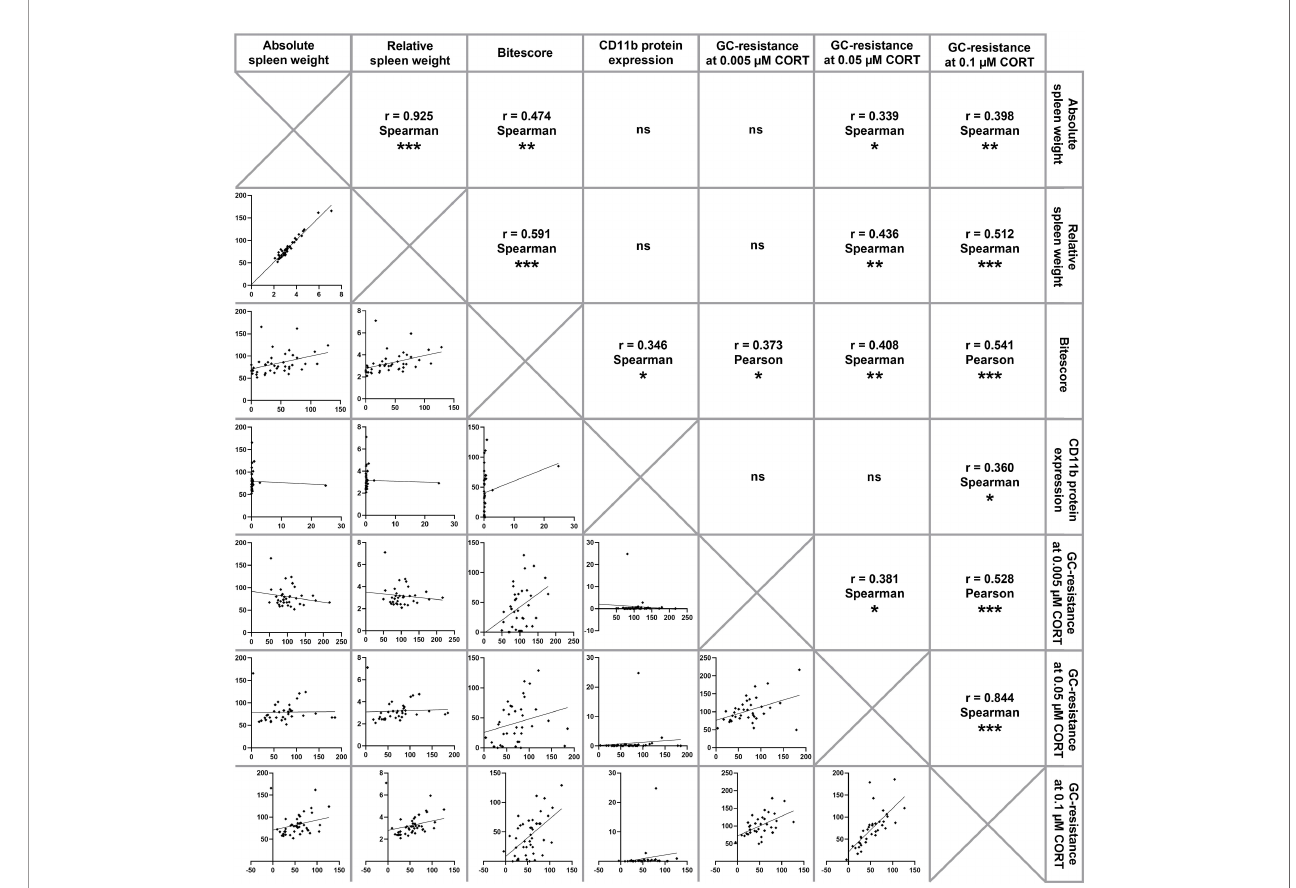
FIGURE 3 | Correlation analysis. Depicted are correlations between absolute and relative spleen weight, bite score, splenic CD11b protein expression and functional splenic glucocorticoid (GC) resistance at 0.005 µM, 0.05 µM and 0.1 µM corticosterone (CORT), respectively. Of note, CSC mice of all time points have been pooled for running correlational analyses, which were done using either Pearson correlations (both parameters normally distributed) or Spearman correlations (at least one parameter not normally distributed). Signi fi cant correlations are indicated by * P ≤ 0.05, ** P ≤ 0.01, *** P ≤ 0.001, ns, not signi fi